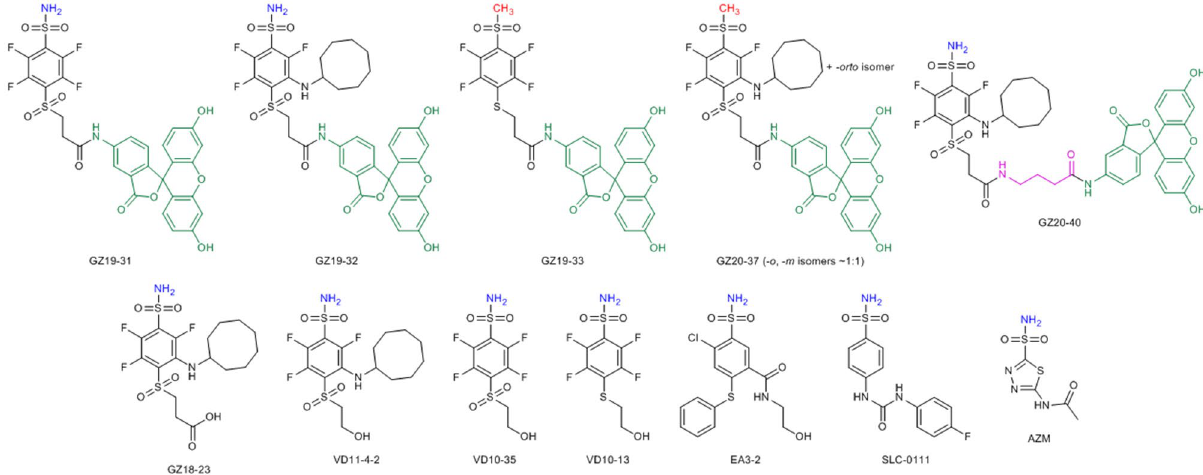
Figure 1. Chemical structures of fluorescein-labeled compounds (upper row) and several unlabeled compounds (lower row). Their affinities for CAIX on the cell surface were measured by the competition assay (described below). The amine of the sulfonamide group is shown in blue, while the methyl for non-inhibitors— in red. Fluorescein is shown in green and the extended linker—in